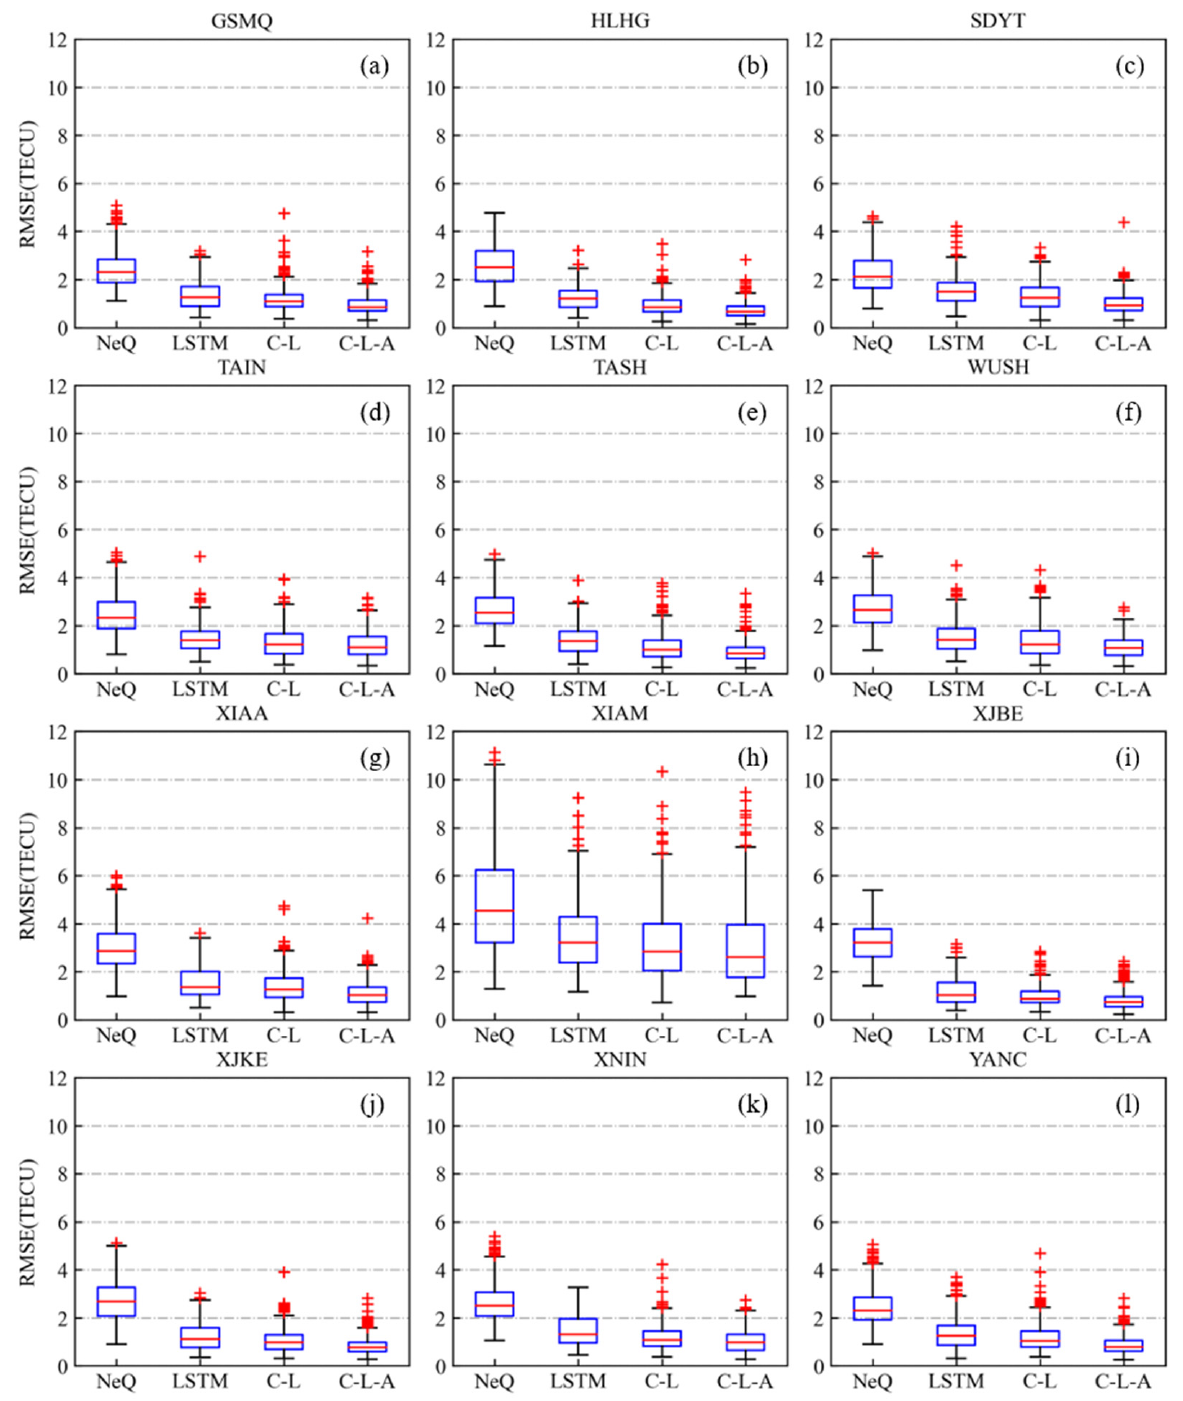
Figure A2. ( a – l ) The RMSE of NeQuick, LSTM, CNN-LSTM, and CNN-LSTM-Attention models from other 12 GNSS stations. The top and bottom black bars represent the maximum and minimum values, respectively. The upper and lower edges of the blue box represent the upper quartile and the lower quartile, respectively. The middle red bar represents the median, and the red plus sign represents the outlier.